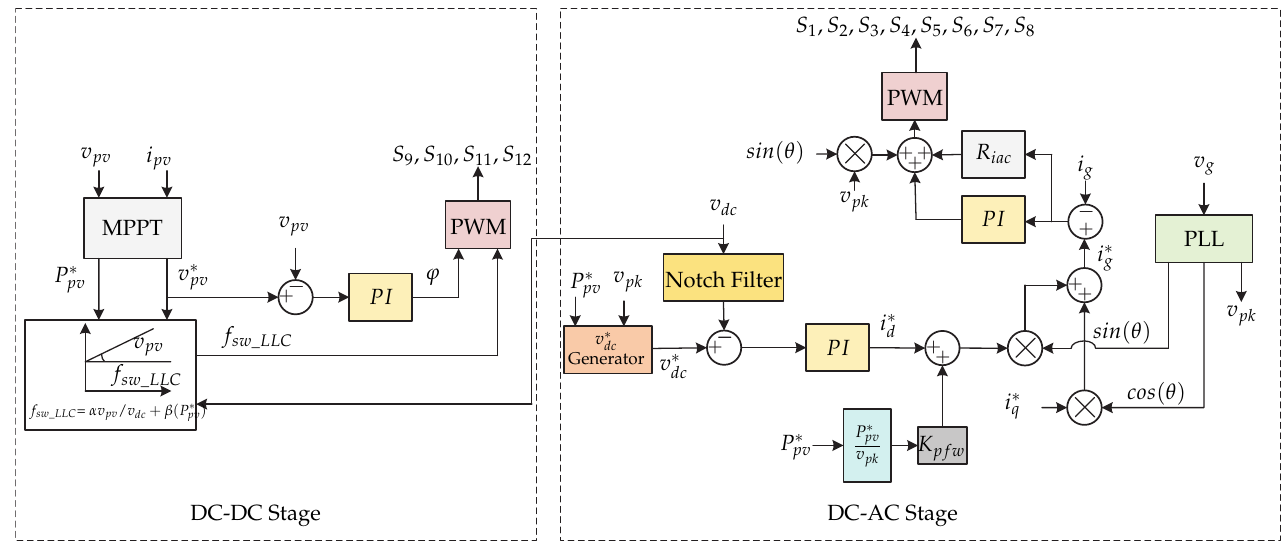
Figure 27. Control strategy proposed in [64].